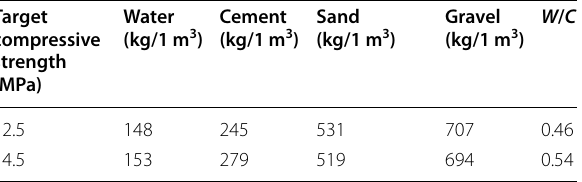
Table 3 Mechanical properties of